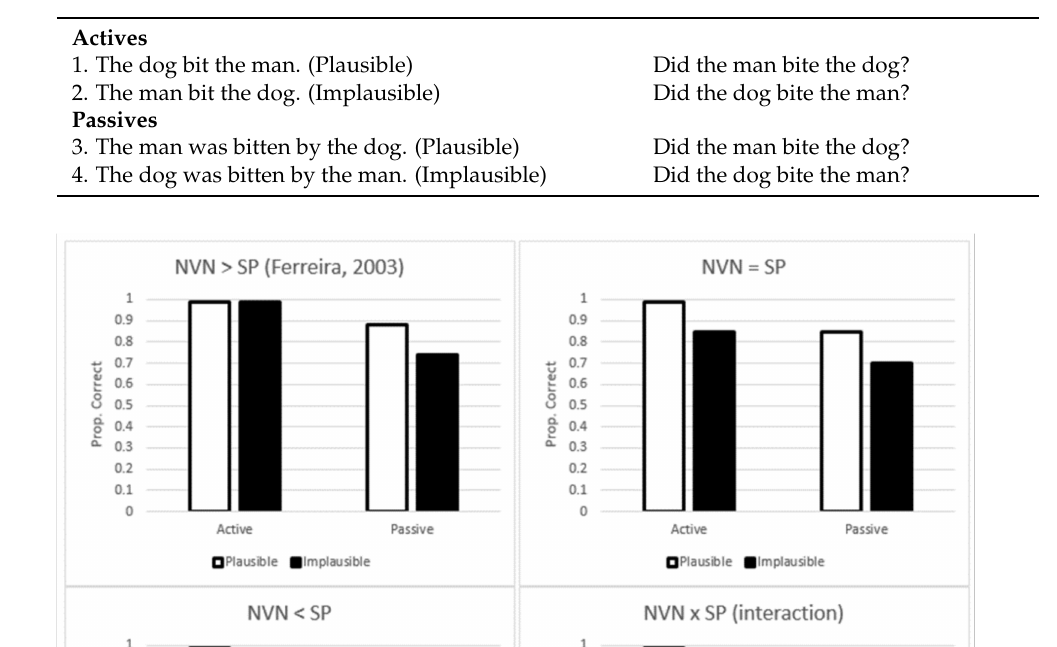
Table 1. Example stimuli showing passive and active and plausible and implausible sentences, and the associated comprehension questions.